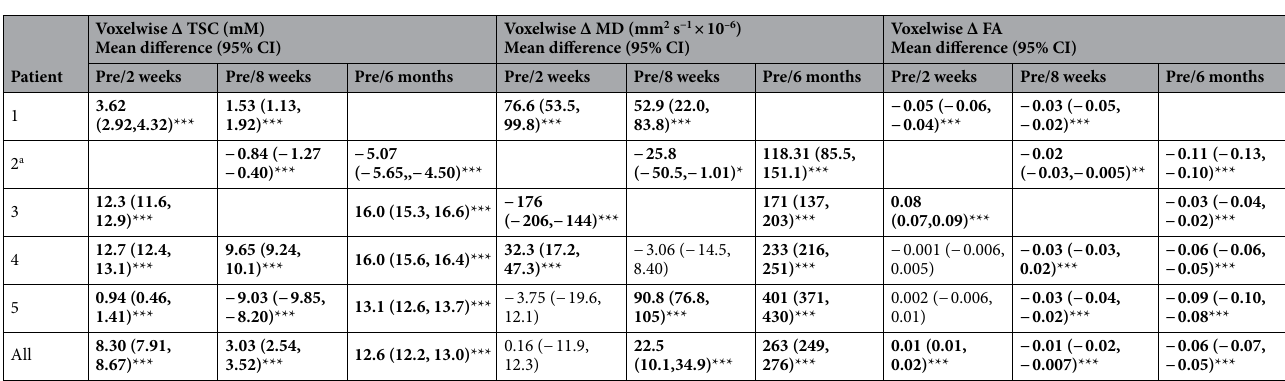
Table 3. Voxelwise temporal changes in tumour total sodium concentration (TSC), mean diffusivity (MD) and fractional anisotropy (FA). Statistically significant values ( p ≤ 0.05) are shown in bold P value calculated using repeated measures ANOVA or repeated measures mixed-effects model. Post hoc analysis of pairwise comparisons between different timepoints was performed using the Bonferroni method. *** ≤ 0.001; ** ≤ 0.01; * ≤ 0.05. a Difference from 2 week post-treatment timepoint shown as no pre-treatment imaging